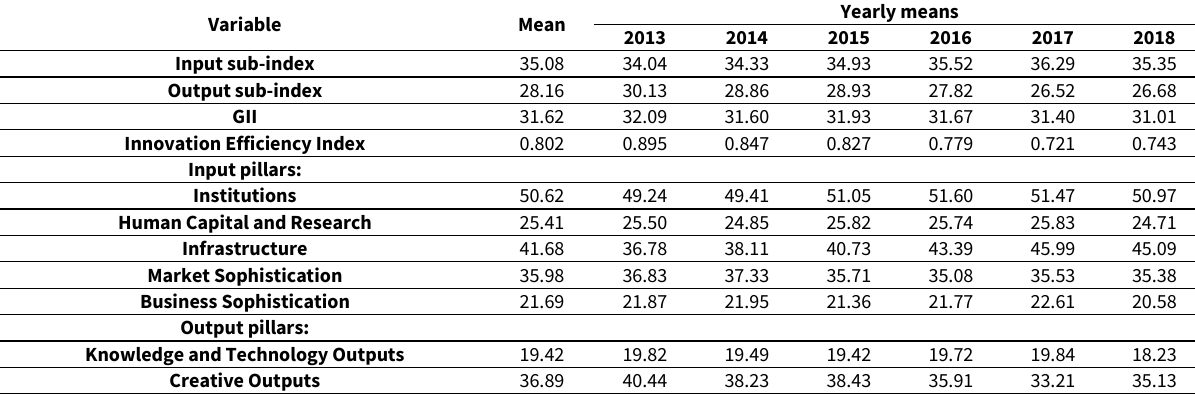
Table 2. Mean scores and yearly